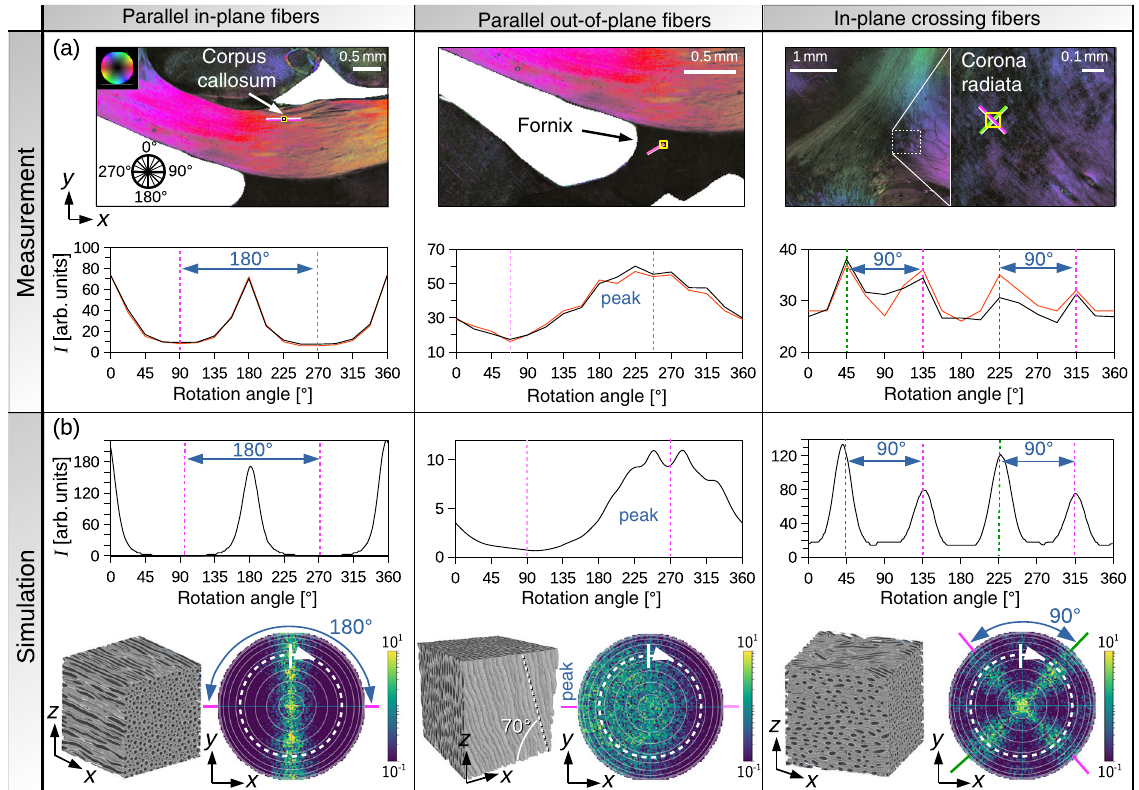
FIG. 9. Scattering measurement of a coronal vervet brain section in comparison to simulated scattering patterns. (a) The scattering measurement is performed as described in Appendix A 5 with a pixel size in object space of 6 . 3 μ m and a mask with a circular hole with a fixed polar angle of illumination of 47 . 6 ° and rotation angles of f 0 ° ; 22 . 5 ° ; … ; 337 . 5 ° g . Three regions with parallel in-plane fibers (corpus callosum), parallel out-of-plane fibers (fornix), and in-plane crossing fibers (corona radiata) are selected for evaluation. The images in the top row show the fiber orientation maps obtained from a 3D-PLI measurement with 1 . 33 μ m pixel size (the fiber orientation map of the whole brain section is shown in Fig. 1). The selected regions ( 10 × 10 pixels) are marked by a small square, and the in-plane orientations of the nerve fibers (derived from visible structures and/or anatomical knowledge) are marked by purple and green lines. The second row shows the average transmitted light intensity I in the evaluated regions plotted against the rotation angle of the mask (black curves). The red curves show the transmitted light intensity of the middle pixel ( 1 × 1 pixels) in the selected regions. The dashed vertical lines indicate the orientations of the fibers as marked in the fiber orientation maps. (b) The bottom row shows artificial fiber bundles and the simulated scattering patterns (cf. Fig. 7): parallel in-plane fibers, parallel out-of-plane fibers with 70° inclination, and interwoven crossing fibers with a 90° crossing angle. The green and purple lines around the scattering patterns indicate the main orientations of the artificial fibers. The white dashed circle indicates the angle under which the sample is illuminated in the measurement ( 47 . 6 °). The graphs above show the intensity of the corresponding scattering pattern, evaluated along the dashed circle in the clockwise direction starting at the top (see the white arrow in the scattering pattern). To account for the finite size of the hole of illumination, a Gaussian blur with a diameter of 8° in angular space is applied to the scattering patterns before